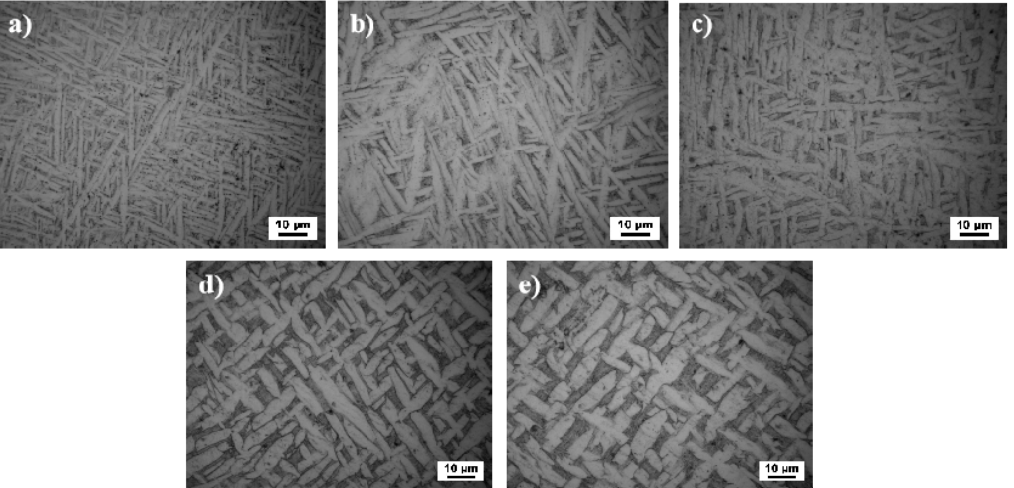
New Fig.4 （ ） edited in manuscript Normalizing microstructure at different Figure 4. Normalizing microstructure at di ff erent temperatures. ( a ) As-deposited, ( b ) 810 ◦ C / 2 h / AC, temperatures(OM). (a) As-deposited, (b) 810 °C/2 h/AC, (c) 870 °C/2 h/AC, (d) 930 °C/2 h/AC,